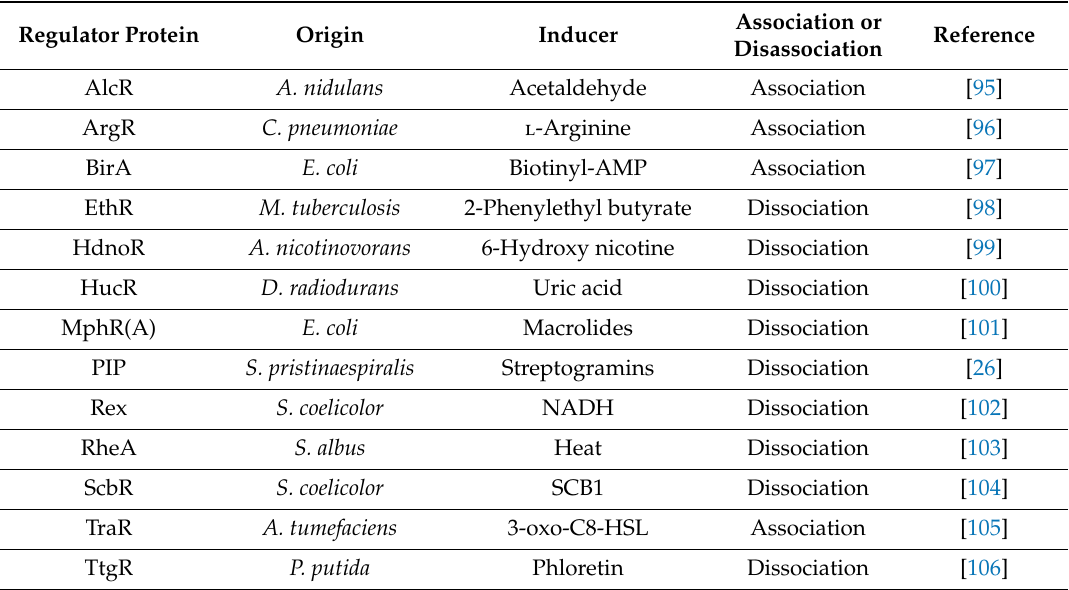
Table 1. Bacterial operators other than LacO, TetO and CuO.